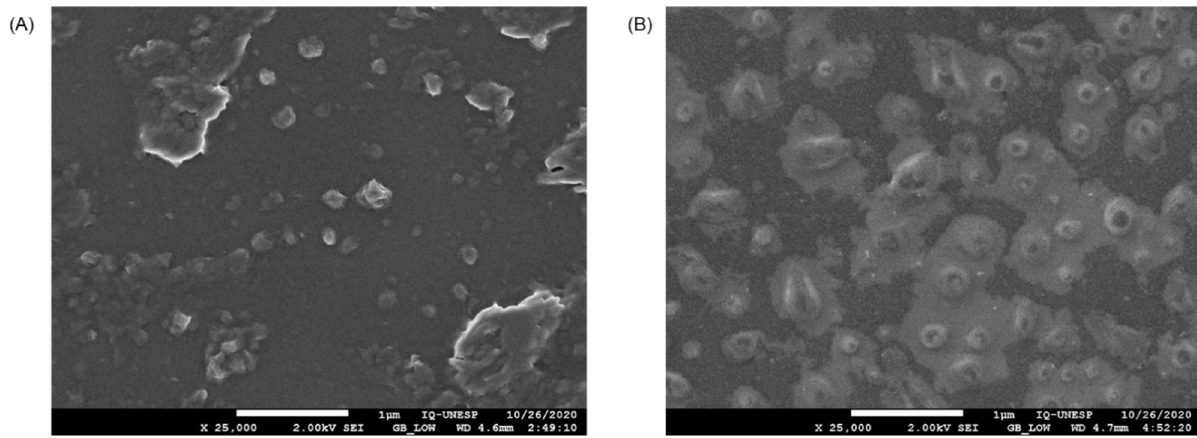
Figure 5. High-resolution field emission scanning electron microscopy (SEM) of PG-PN ( A ) and EMP-PN ( B ).